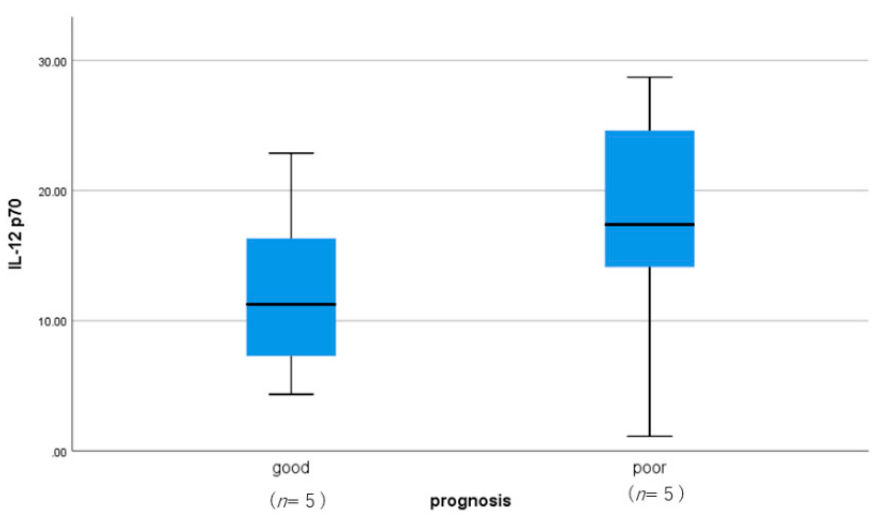
Figure 4. Comparison of CSF IL12 (p70) levels in patients with influenza-associated encephalopathy with good and poor prognoses.